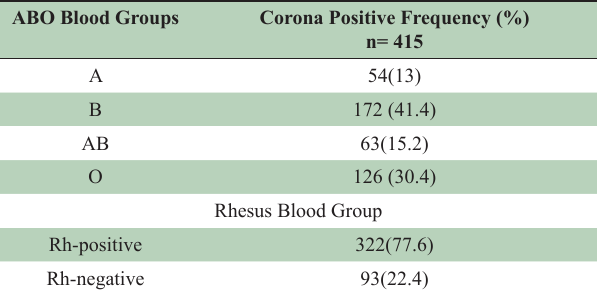
are less apprehended for following the precautionary measures than the male population 135(83.3%). Table-I: Corona Positive Patients among Blood Groups (n= 415).